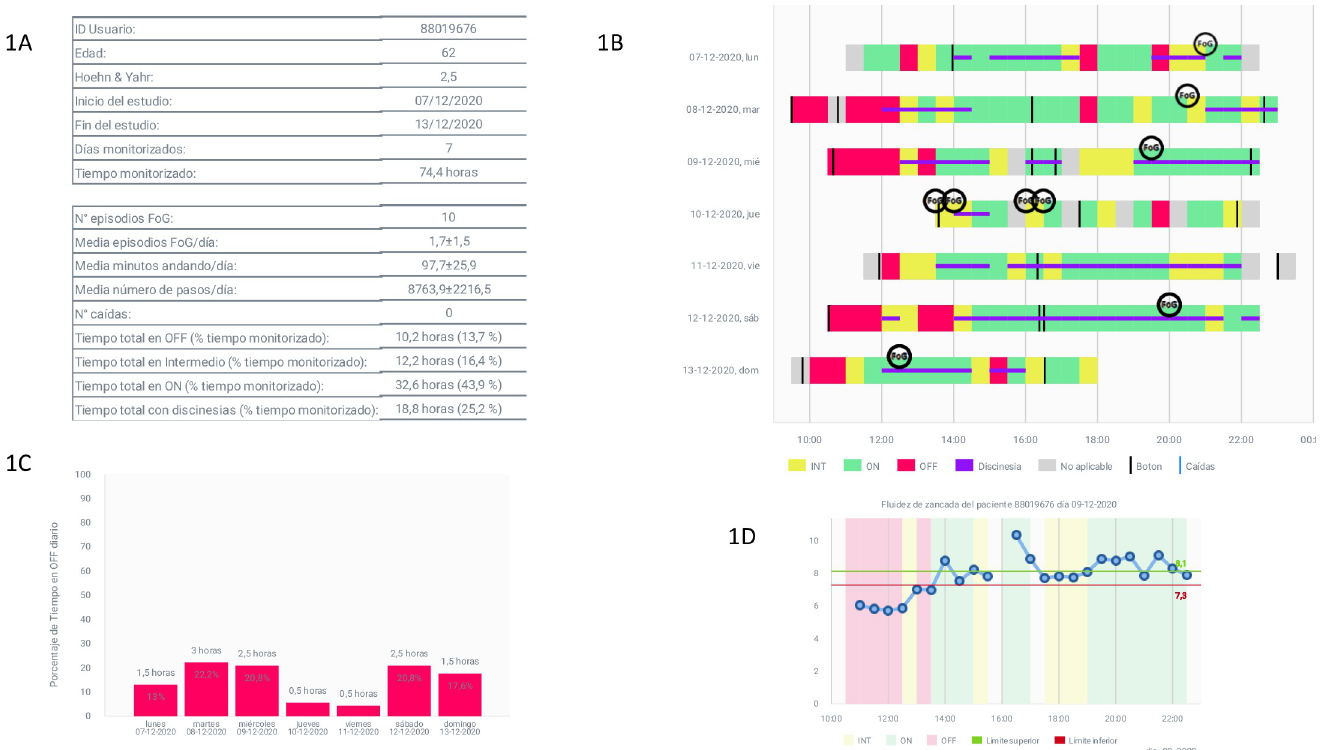
Fig 1. Examples of sensor patients’ results. A . Example of the first page of the STAT-ON TM report. It contains information regarding the total time of monitorization along the 7-day-period. B. Example of the report that is shared with the patient. Color legend. Green: On state; Red: Off state; Yellow: Intermediate state; Grey: Inactivity or rest state. No walking detection; Freezing of Gait (FoG) is represented by a black round; Horizontal purple line: Dyskinesia; Vertical black line: Button event (in the present study, corresponds with the levodopa dose); Vertical blue line: Fall. C . The figure shows the total time and the percentage of Off state of every day. The height of each bar depends on the percentage of Off-Time per day. D . This figure shows the GF along the day of the third day of monitoring of the same patient of the STAT-ON TM report above. The GF is worse in the morning.